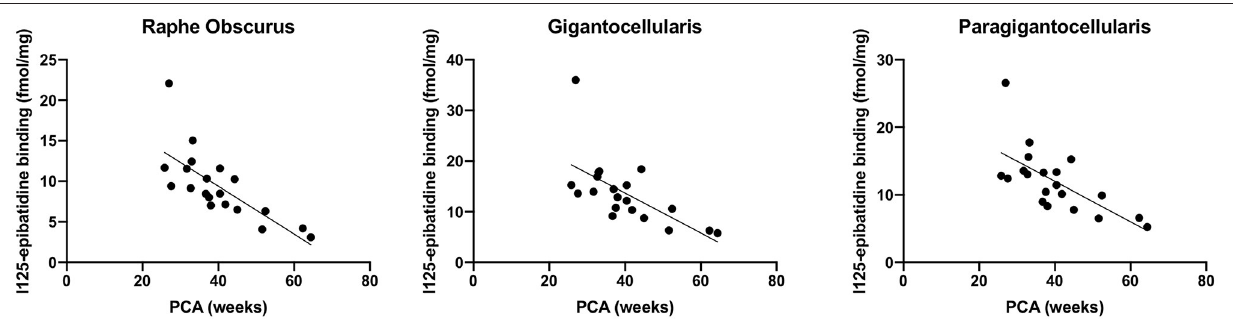
binding than SIDS (12.1 ± 0.9 fmol/mg and 9.1 ± 0.8